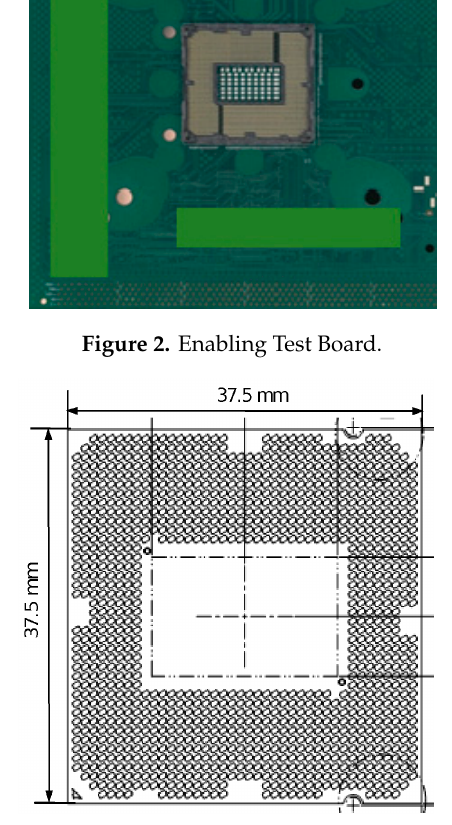
Figure 2. Enabling Test